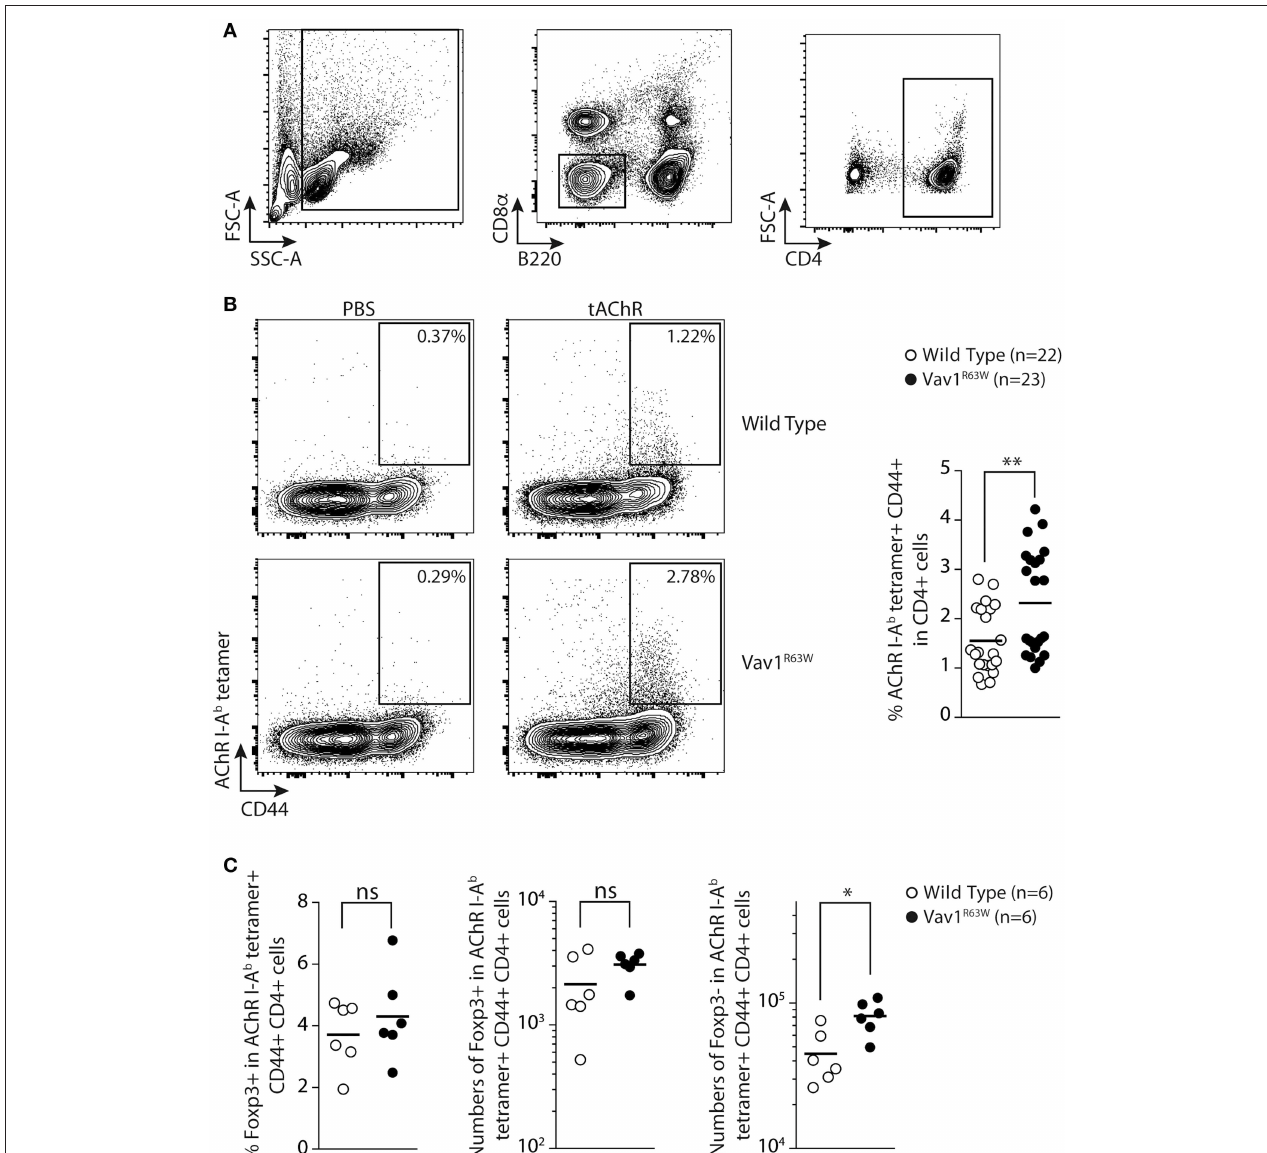
FIGURE 5 | Tracking AChR-specific CD4 + T cells in WT and Vav1 R63W KI mice. Nine days after sub-cutaneous immunization, draining LN were harvested and analyzed by flow cytometry. The gating strategy of total CD4 + T cells is depicted in (A) by excluding B220 + and CD8 α + cells and by positively selecting CD4 + cells. The detection of tAChR-specific activated CD4 + T cells (AChR I-A b tetramer + CD44 + ) are depicted for wild-type and Vav1 R63W KI mice after immunization with PBS in CFA or tAChR in CFA (B) ( n = 22 for wild-type mice and n = 23 for Vav1 R63W KI mice). Data represent a pool of 4 independent experiments. Intracellular expression of Foxp3 was assessed in tAChR-specific CD4 + T cells. Frequency of Foxp3 + Treg and absolute numbers of Foxp3 + Treg and Foxp3- effector tAChR-specific CD4 + T cells are depicted (C) ( n = 6 for wild-type mice and n = 6 for Vav1 R63W KI mice). Each dot represents an individual mouse; horizontal lines denote the mean value of groups. Mann-Whitney test, * P < 0.05, ** P <